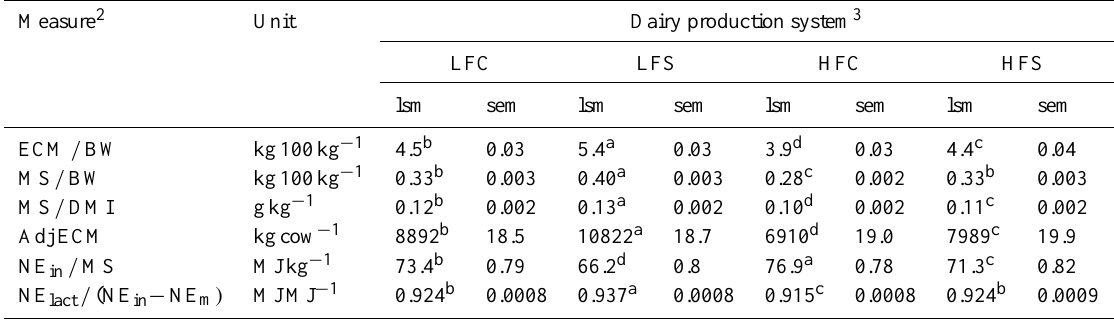
Table 3. Estimated production efficiency and energetic-efficiency measures presented as least squares means 1 (lsm) with standard errors of the mean